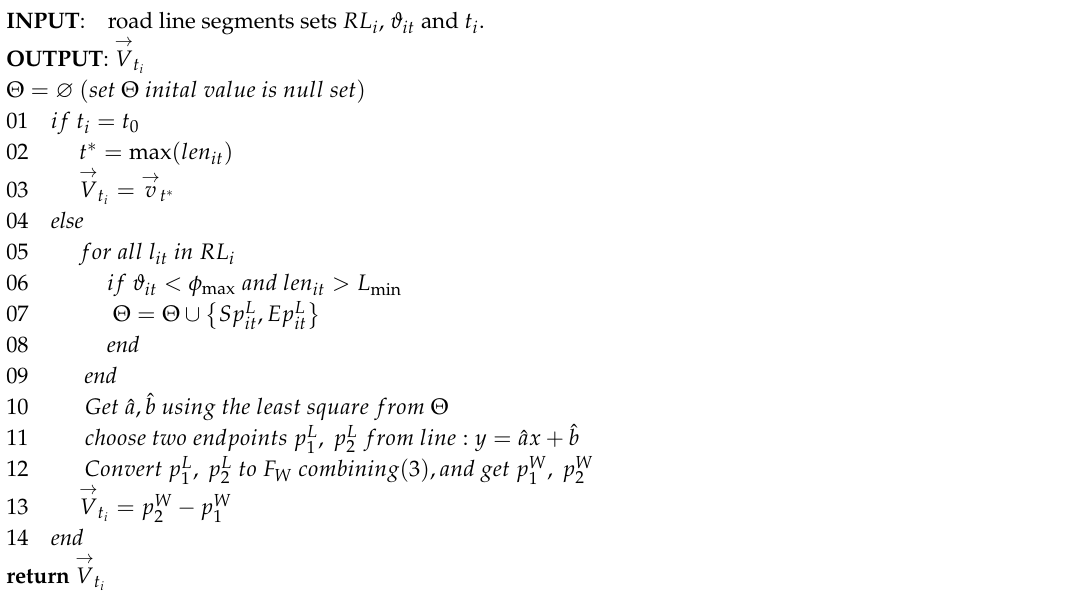
Algorithm 2: Extract the vector of scanned road